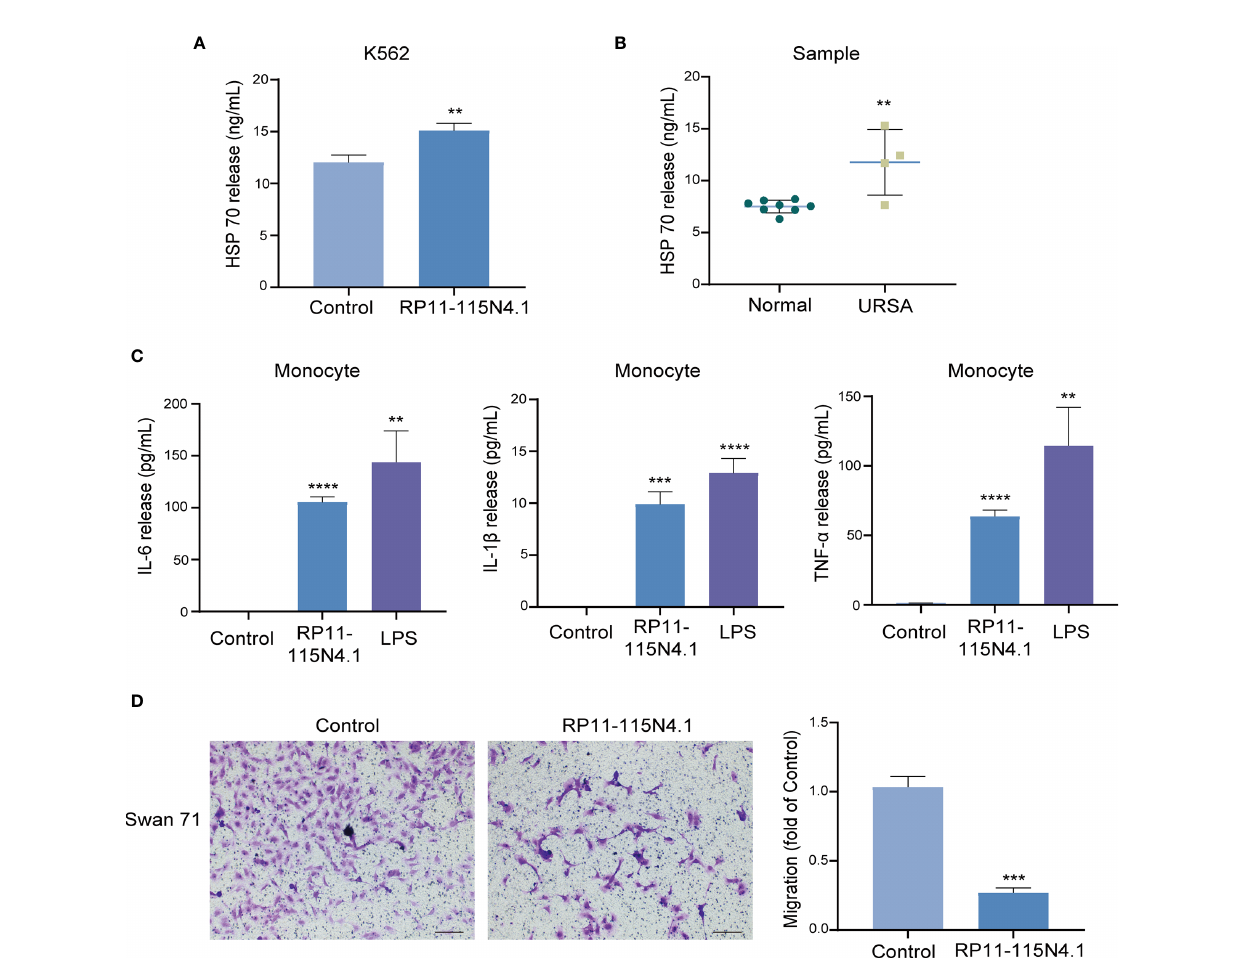
FIGURE 5 | The supernatant of K562 cells overexpressed RP11-115N4.1 induced the in fl ammatory response of monocytes and inhibited the migration of trophoblast cells. (A) The level of HSP70 was determined by ELISA in K562 cell treated with RP11-115N4.1. (B) The level of HSP70 was determined by ELISA in the serum of URSA samples with high RP11-115N4.1 expression. (C) The levels of IL-6, IL-1 b and TNF- a were determined by ELISA in human monocyte under different condition. LPS was used as a positive control (100 m g/mL). (D) Transwell assay in Swan 71 cell under different condition. The picture scale was 100 m m. ** P < 0.01, *** P < 0.001, **** P < 0.0001. Each experiment was repeated three times and results are means ±